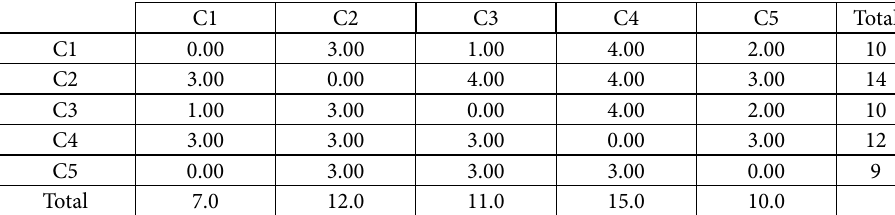
Table 2. Direct influence matrix for inter-cluster relationships